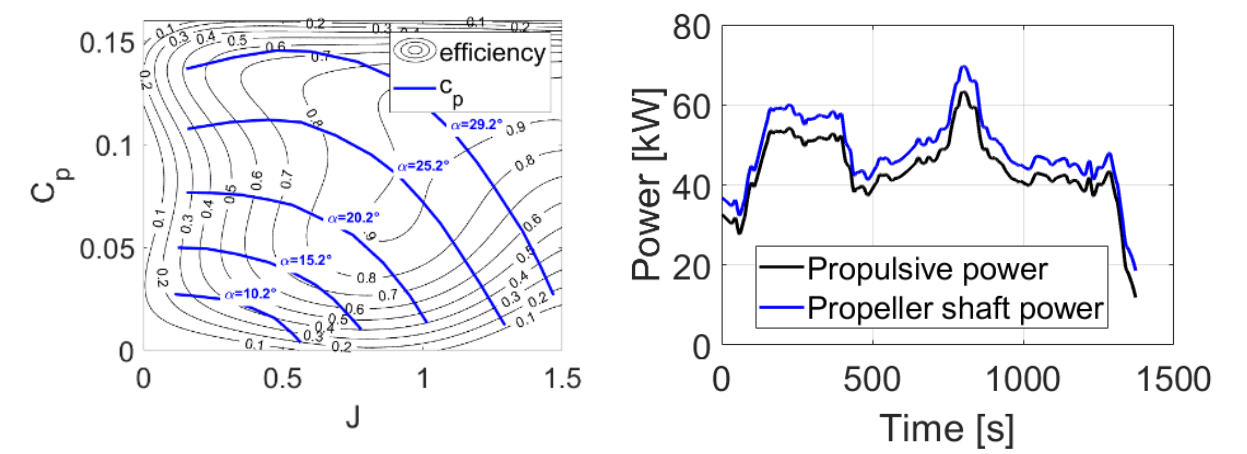
Figure 4. Propeller e ffi ciency map ( left ) and propulsive vs. shaft power ( right ).